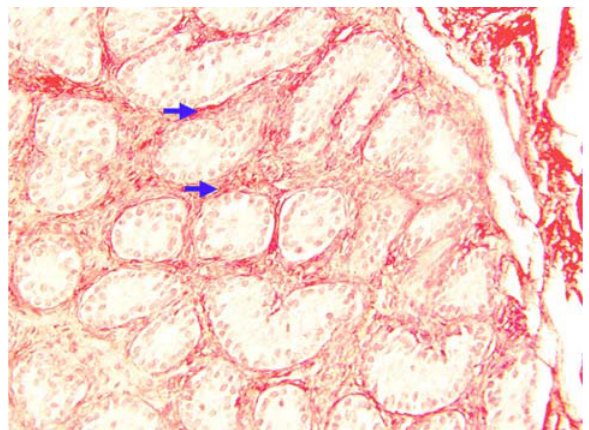
Figure 3 – Photomicrography of testicular parenchyma of a nontreated patient (picrosirius red, X400).